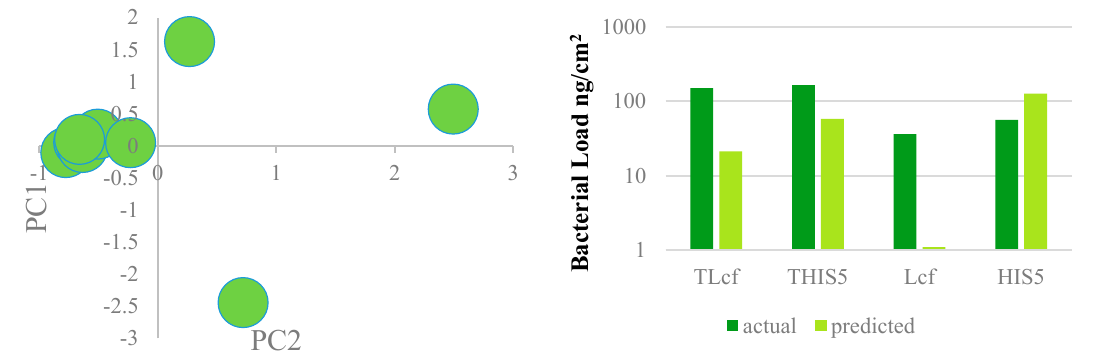
Figure 3. Results on initial datasets, ( A ). principal component analysis (PCA) of 32 descriptor set, ( B ). activity prediction of antibacterial peptides from Shiba et al [19] using multiple linear regression.